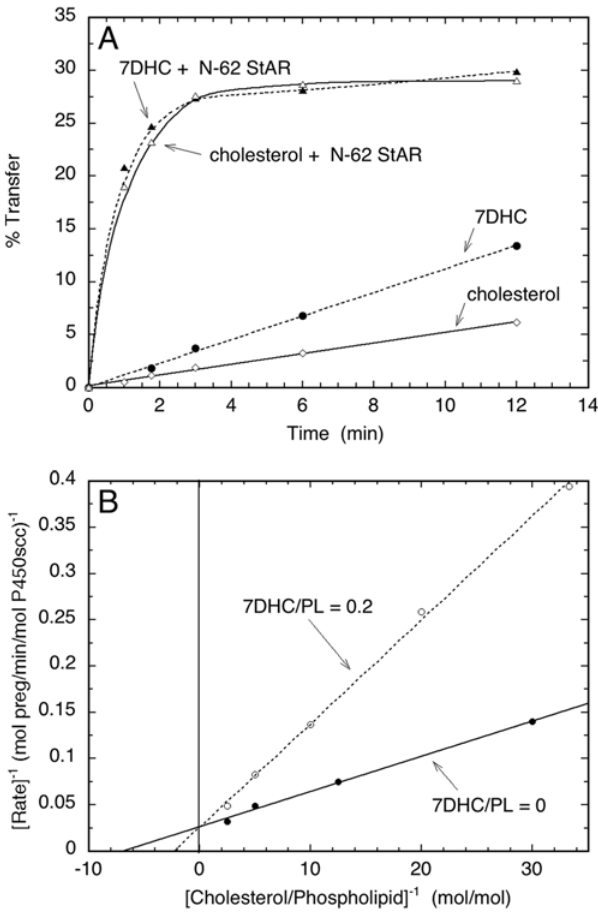
Figure 10. Stimulation of 7DHC transfer between membranes and the inhibition of the side chain cleavage of [cholesterol by 7DHC. A. To study 7DHC transfer between membranes by N-62 StAR protein cholesterol or 7DHC was placed in donor vesicles at a molar ratio to phospholipid of 0.2. The transfer of the sterol to acceptor vesicles at 35 u C was measured in the presence or absence of 5 m M N-62 StAR protein. B. Inhibition of the side chain cleavage of [4- 14 C]choles- terol by 7DHC was determined with substrate and cytochrome P450scc incorporated into phospholipid (PL) vesicles prepared from dioleoyl phosphatidylcholine containing ardiolipin. As indicated in the figure, 7DHC was included in the membrane at a molar ratio to phospholipid of 0.2. The rate of side chain cleavage of [4- 14 C]cholesterol was determined from the amount of [4- 14 C]pregnenolone formed.